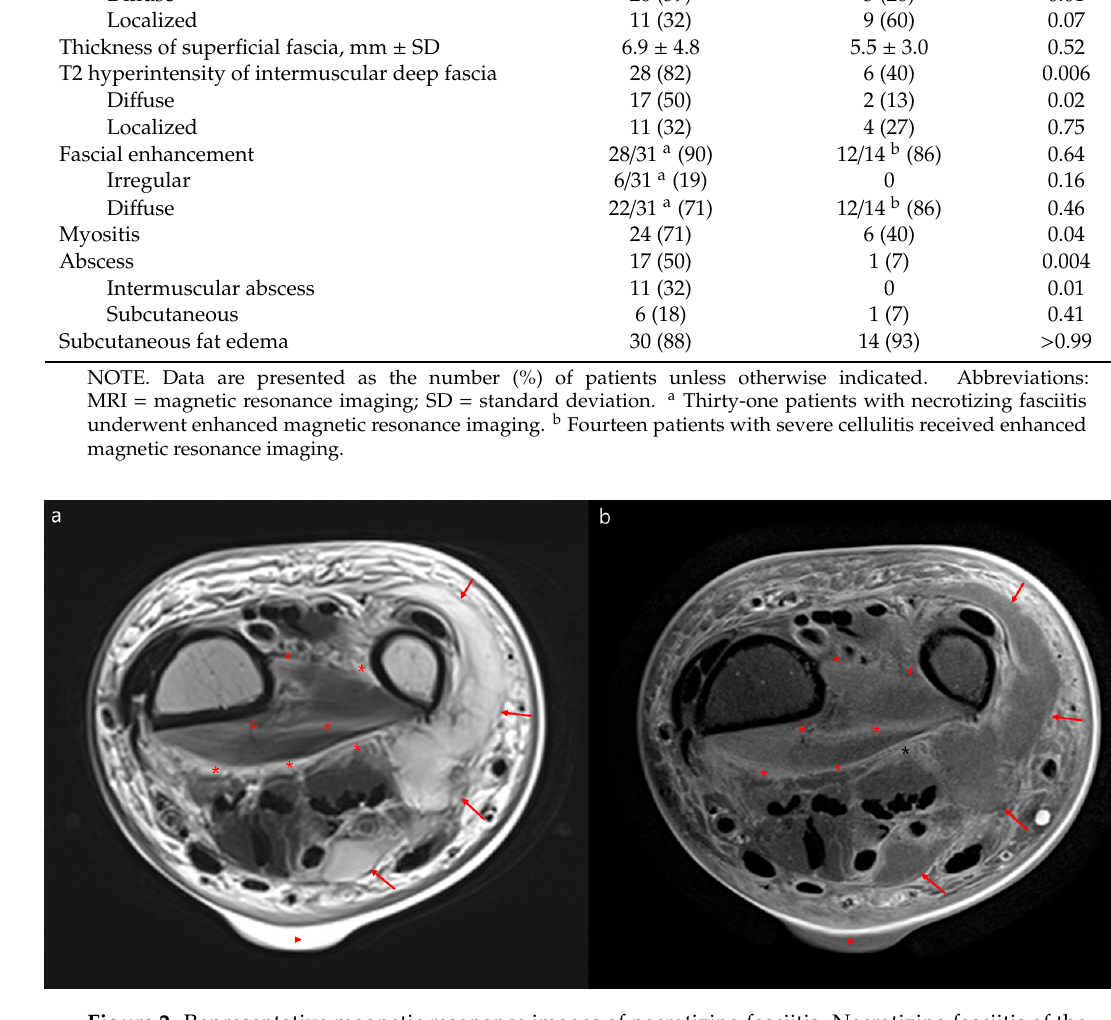
Table 2. Magnetic resonance findings of necrotizing fasciitis and severe cellulitis.